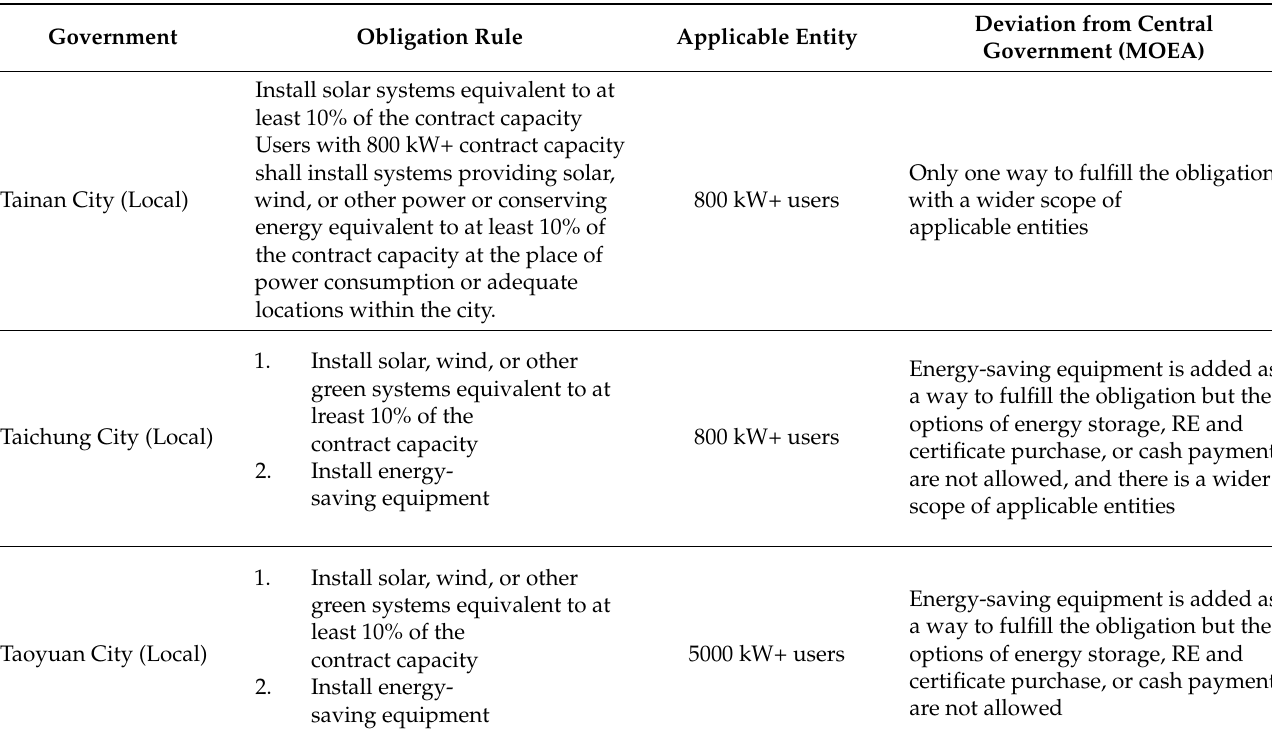
Table 5. Variations in obligation rules between local